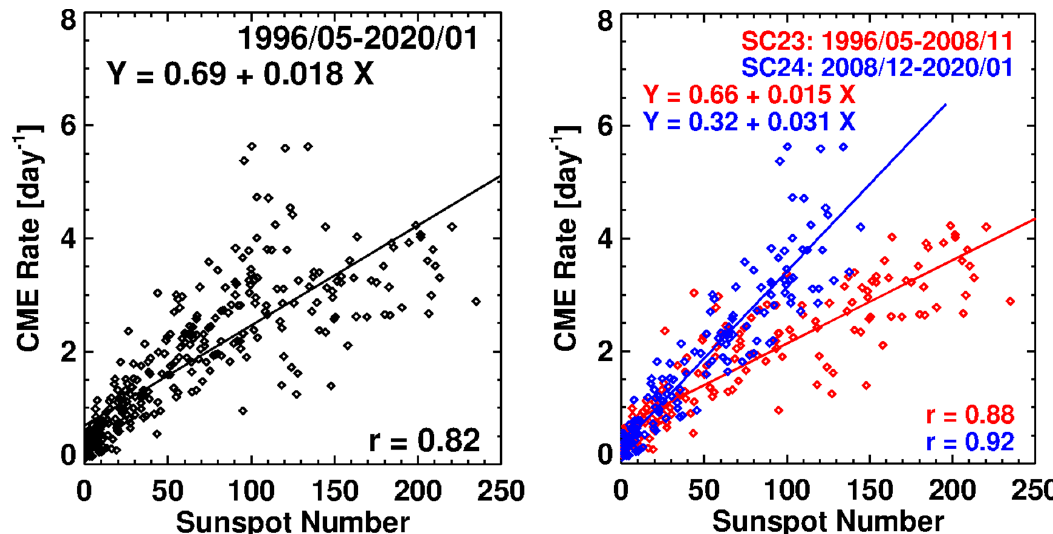
Figure 20. Scatter plot between the sunspot number and CME occurrence rate for the whole SOHO observing period until the beginning of the year 2020 ( left ) and separately for cycles 23 and 24 ( right ). The lower correlation on the left plot is because the relationship changed in cycle 24 compared to cycle 23. For example, the high rate around SSN = 100 is entirely due to cycle-24 CMEs. For a given SSN, the CME rate is much larger in SC 24. For SSN = 100, the regression lines indicate a CME rate of 3.42 in SC 24, compared to 2.16 in SC 23. The scatter plot will be revisited after checking whether CME identification made by different people might have affected the CME rate, especially those with widths close to 30°.